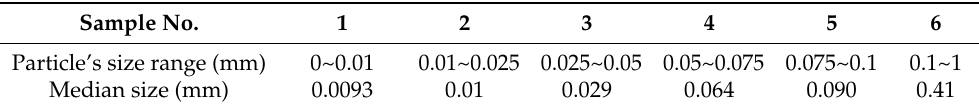
Table 2. The particle grain size of lunar regolith. Sample No.